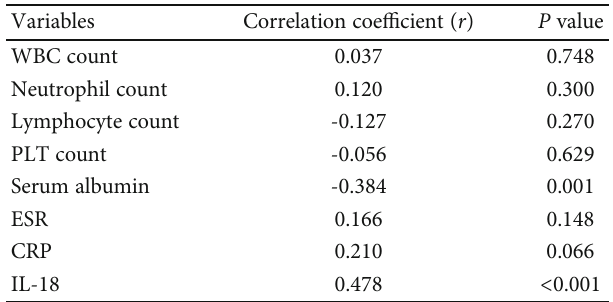
Table 3: Correlation of in fl ammation-related variables and serum IL-18 level with serum IL-27